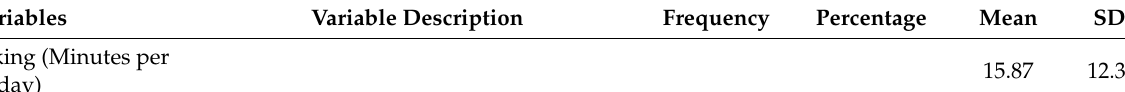
Table 2. Descriptive statistics of socio-demographic variables and familiarity ( N =